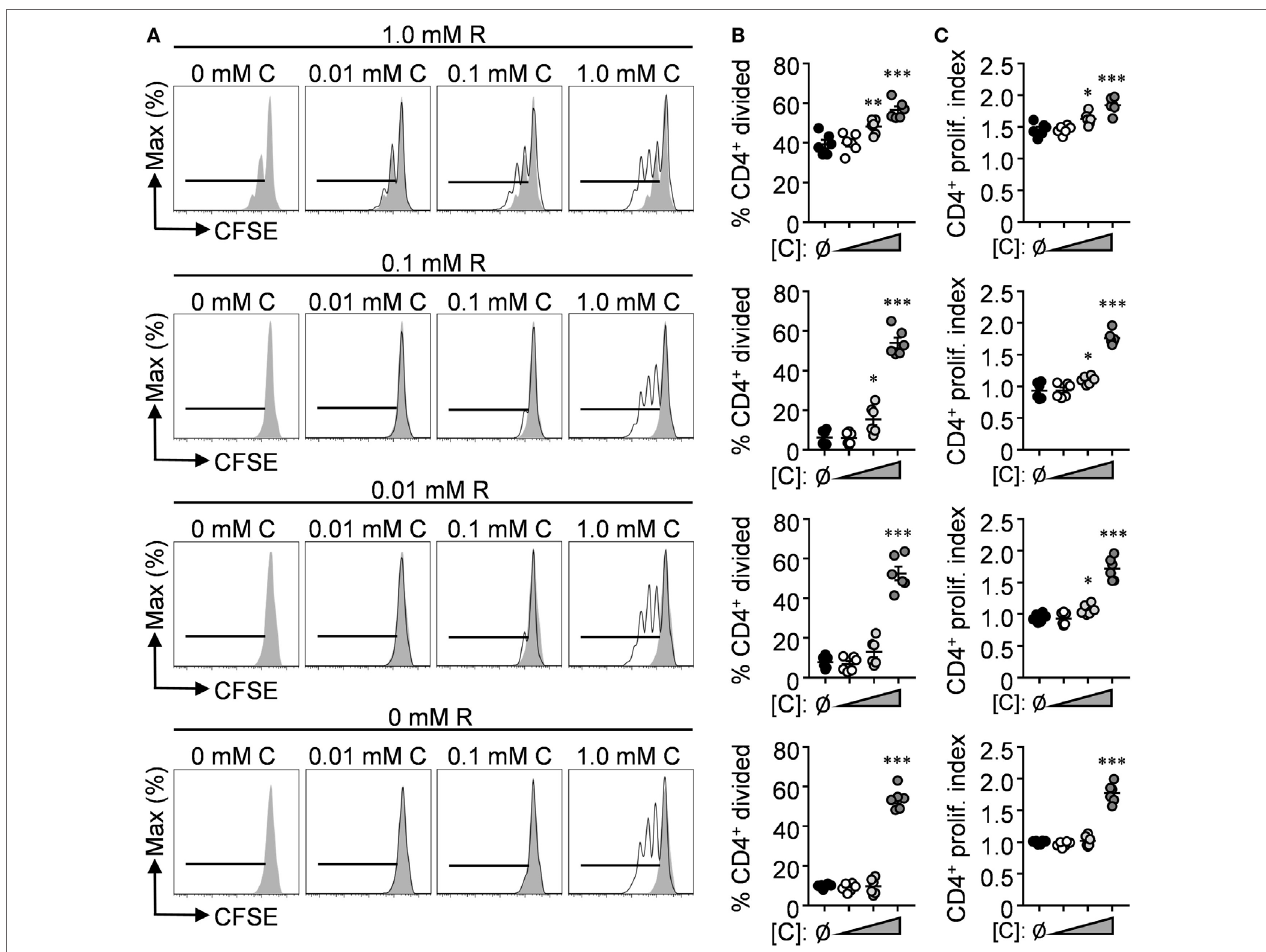
FigUre 4 | l - c itrulline enhances mycobacterium-specific T cell proliferation in l -arginine-sufficient culture. (a–c) Carboxyfluorescein succinimidyl ester (CFSE)- labeled lymphocytes from P25 mice were cocultured with HK-BCG-pulsed wild-type macrophages for 72 h with titrating concentrations of l -arginine ( a , gray histograms) and l -citrulline ( a , black histograms). CFSE dilution of CD3 + CD4 + T cells was analyzed by flow cytometry. Data are displayed as representative histograms (a) , mean percent of divided cells (B) , and proliferation index (c) as defined in the methods. Data are combined from two experiments. Error bars, SEM. * p < 0.05, ** p < 0.01, *** p < 0.001 compared with no l -citrulline added according to Student’s t